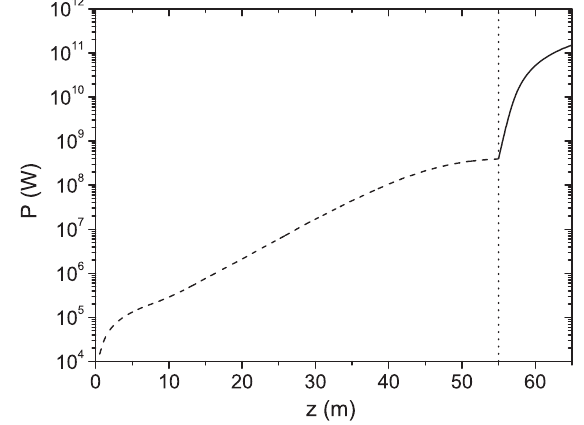
FIG. 6. FEL power versus the length of the planar main undulator SASE3 (dashed) and the helical afterburner (solid).